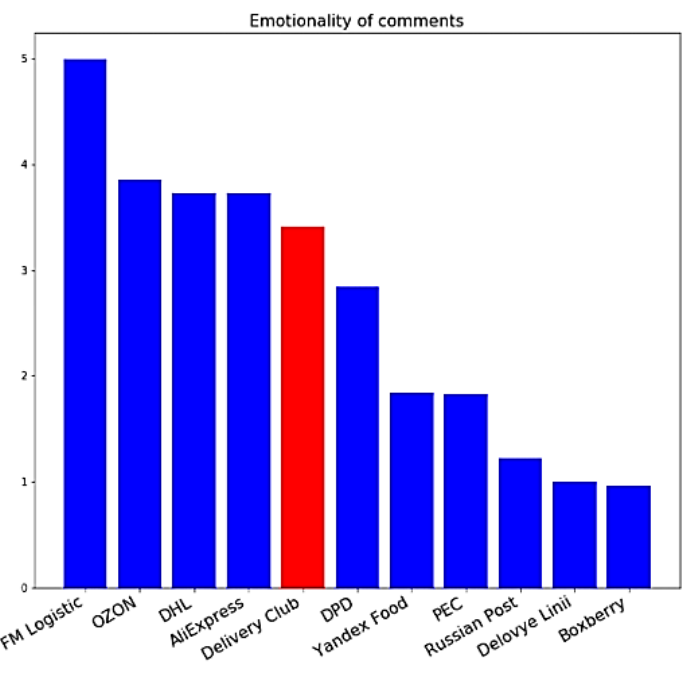
Figure 8. Tonality of comments.